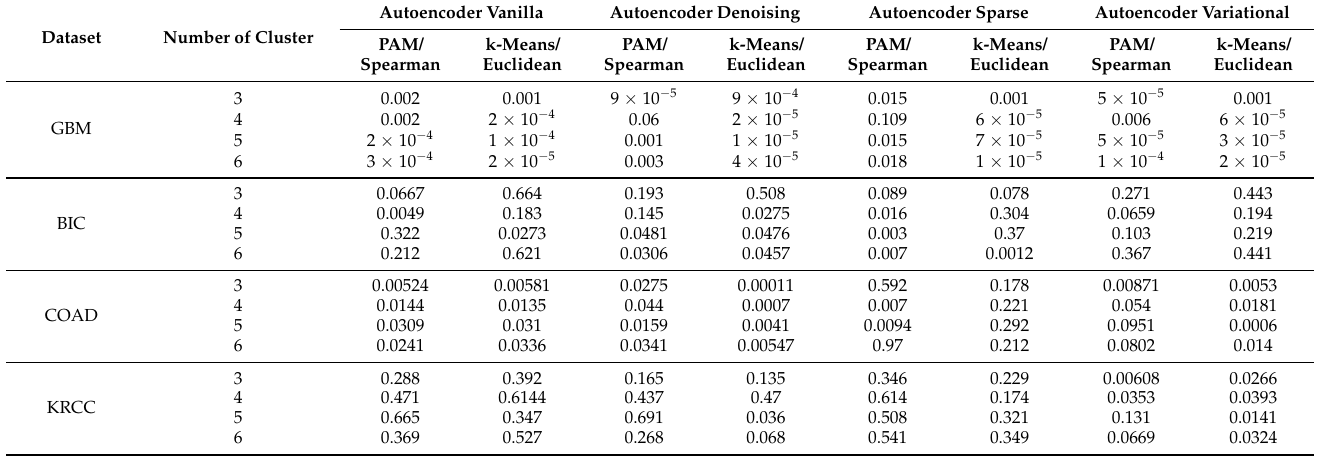
the final cluster prediction. The performance of different autoencoders varies depending upon the dataset, and clearly there is no single winner architecture. Table 1. p -value of survival analysis results for the clusters generated with the autoencoder output. Dataset